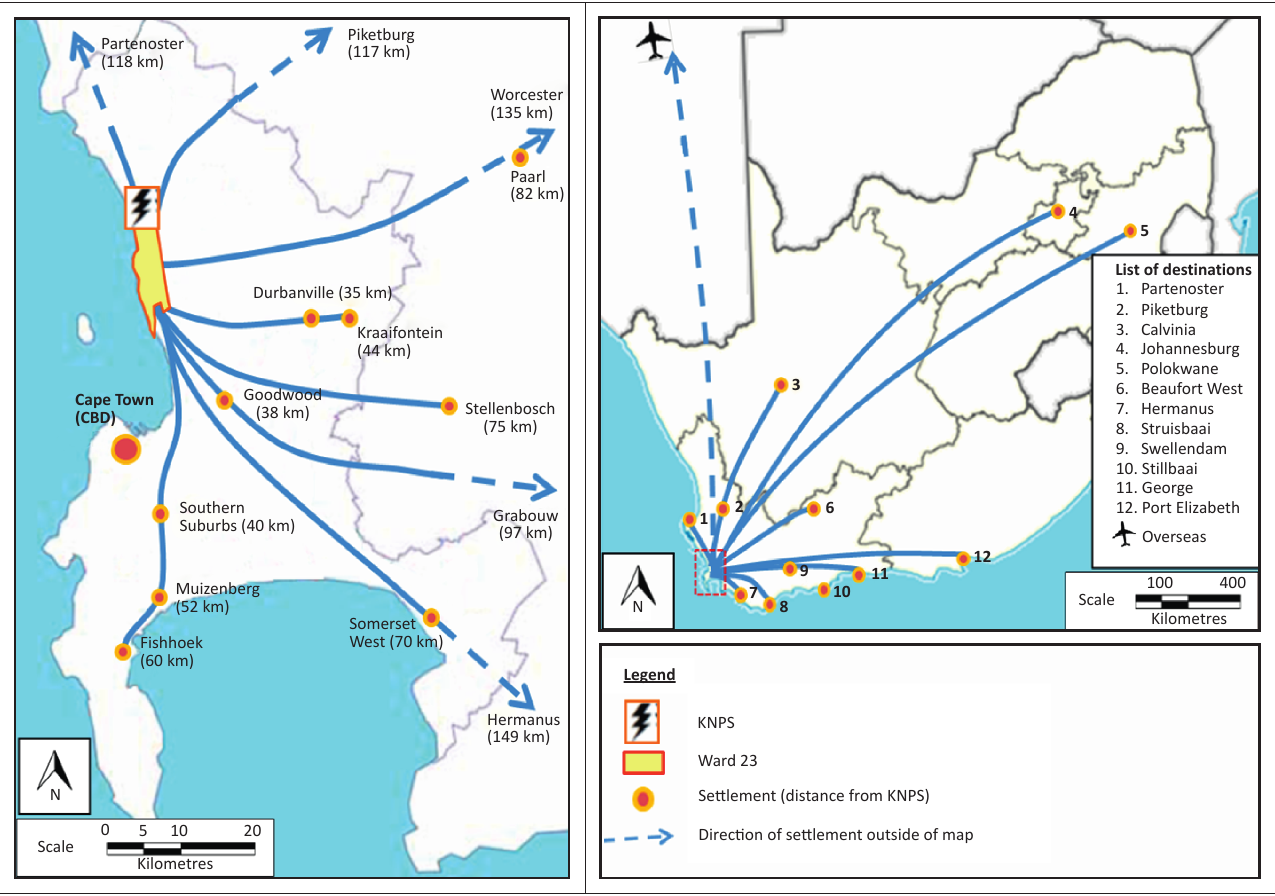
FIGURE 10: Locations to which respondents would evacuate in the event of a general